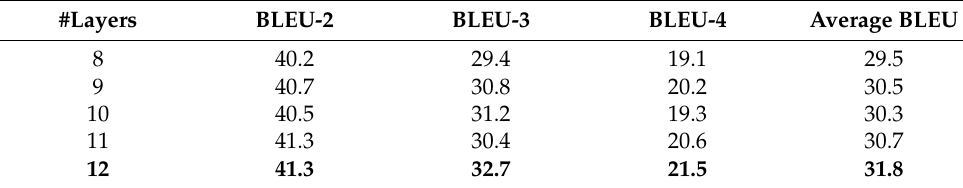
Table 5. BLEU performance of different layers for PBTG’s